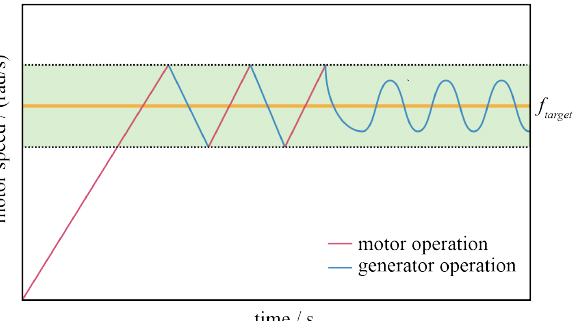
Kyle Retan: Simulative verification of a semi-active broadband energy harvester Figure 11. Desired transient responce of the accelerated pendulum. Figure 11. Desired transient responce of the accelerated pendulum.